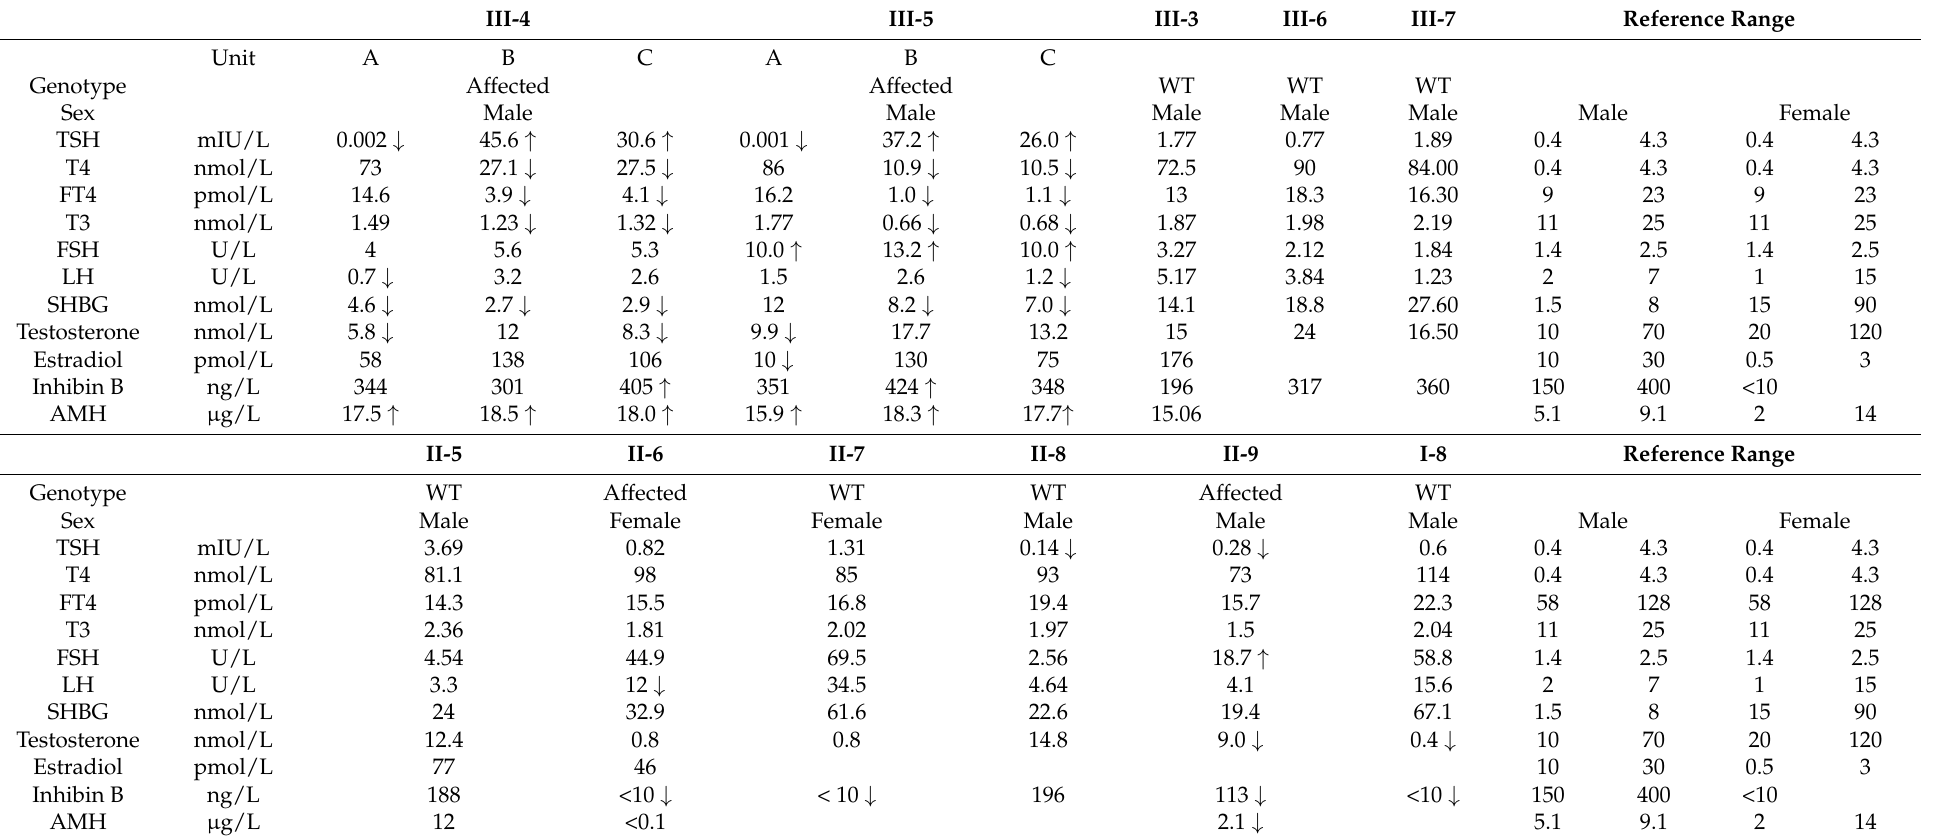
Table 4. Biochemical data of the affected and non-affected